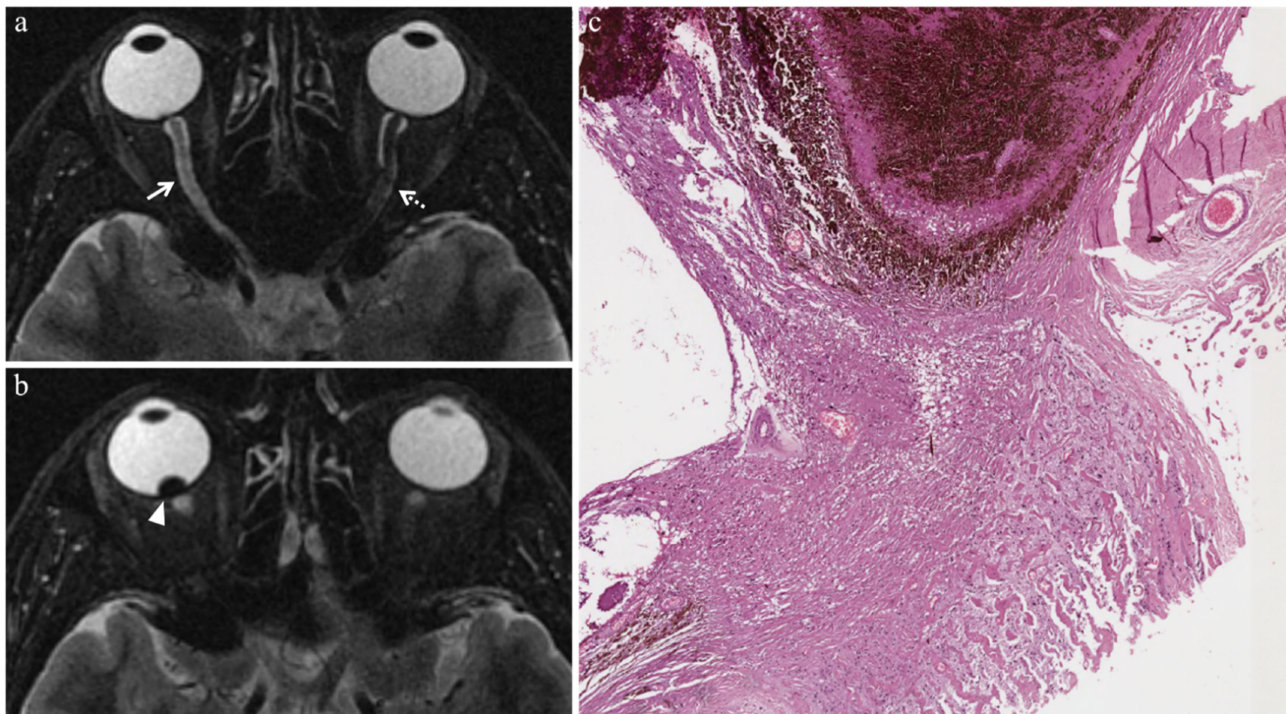
Figure 4. Radiation-induced optic neuropathy. A 44-year-old male patient (patient n. 7 of our series) affected by choroidal melanoma of the right eye treated with proton beam radiotherapy. Secondary enucleation was carried out 32 months after radiotherapy because of tumor progression/local recurrence. ( a , b ) Axial T2-weighted turbo spin-echo STIR images show a choroidal melanoma (white arrowhead in b) located along the posterior margin of the globe, partially covering the optic nerve head. The right optic nerve (white arrow in a) is slightly thinner and more hyperintense than the contralateral one (white dotted arrow in a). ( c ) Histological examination under high magnification (H&E, original magnification 100 × ) showing the close proximity between the tumor and the optic nerve—which appears slightly compressed, but not infiltrated, with initial signs of degeneration (fibrosis and microcystic